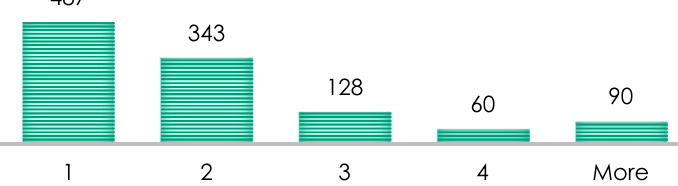
Figure 5. Histogram of number of international articles per author.